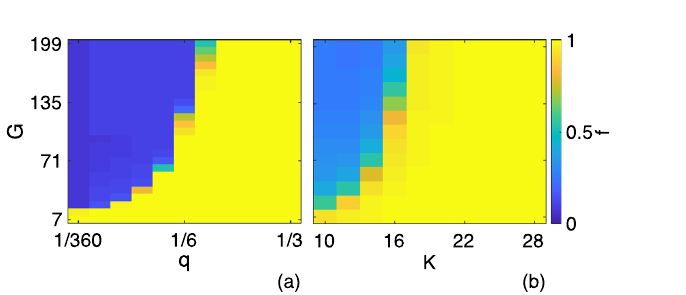
32 , and (b) as a function of K and G with = 400 =